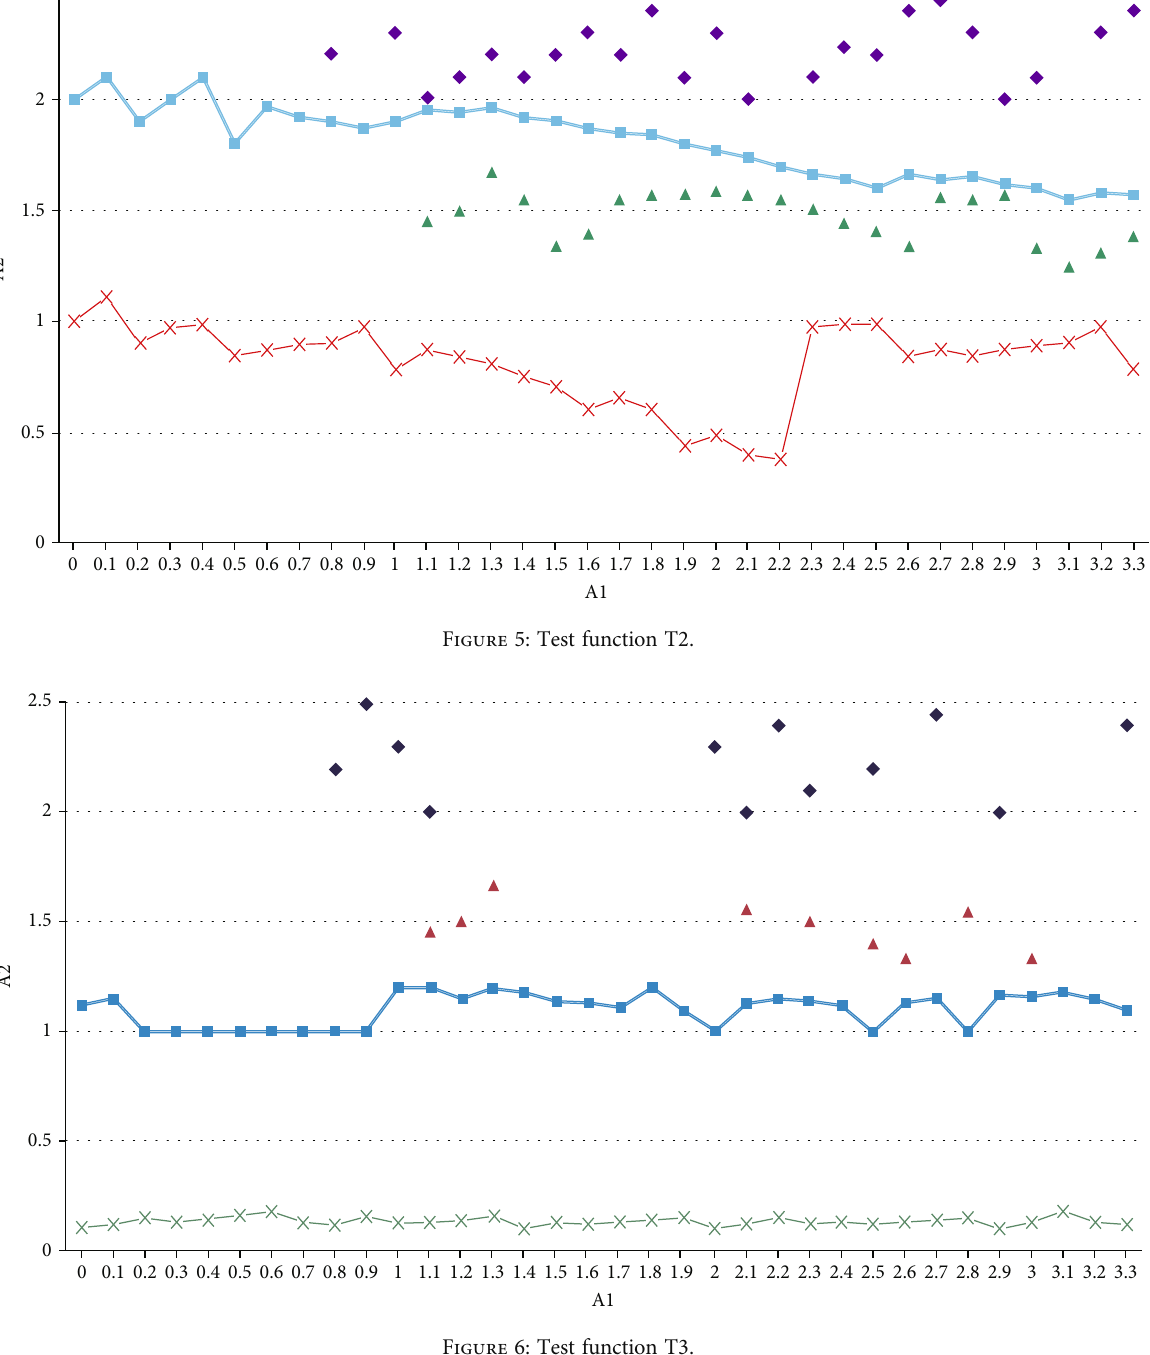
Figure 6: Test function